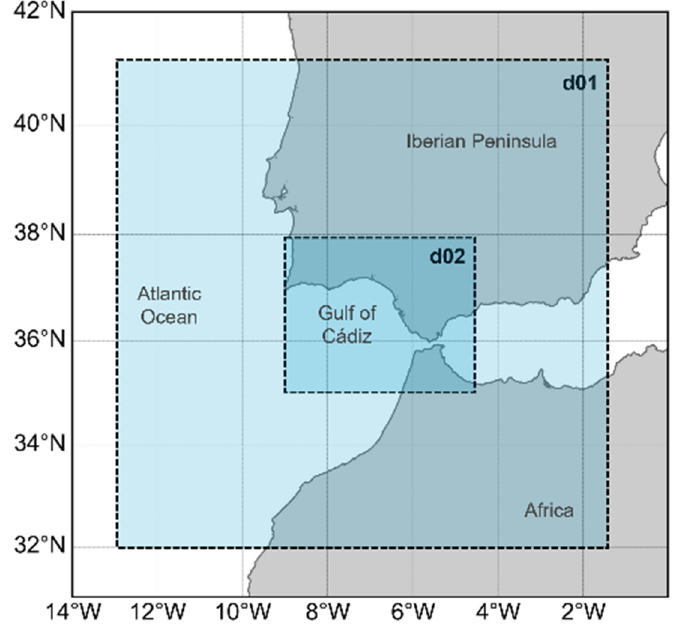
Figure 2. WRF model domains d01 (9 km grid) and d02 (3 km grid).